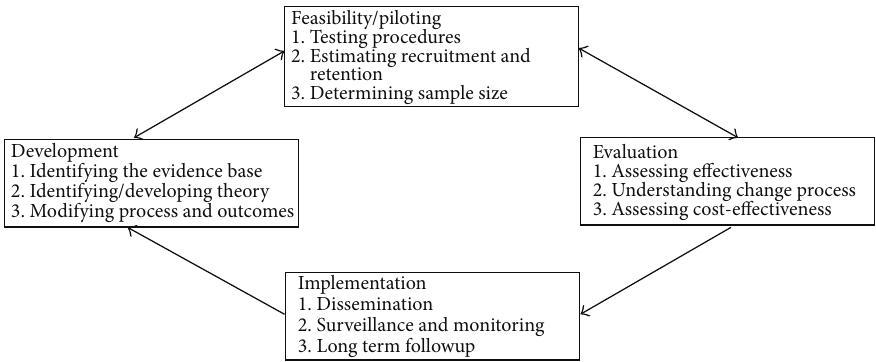
Figure 1: Key elements of the development, evaluation, and implementation process of complex interventions. Source: [2].